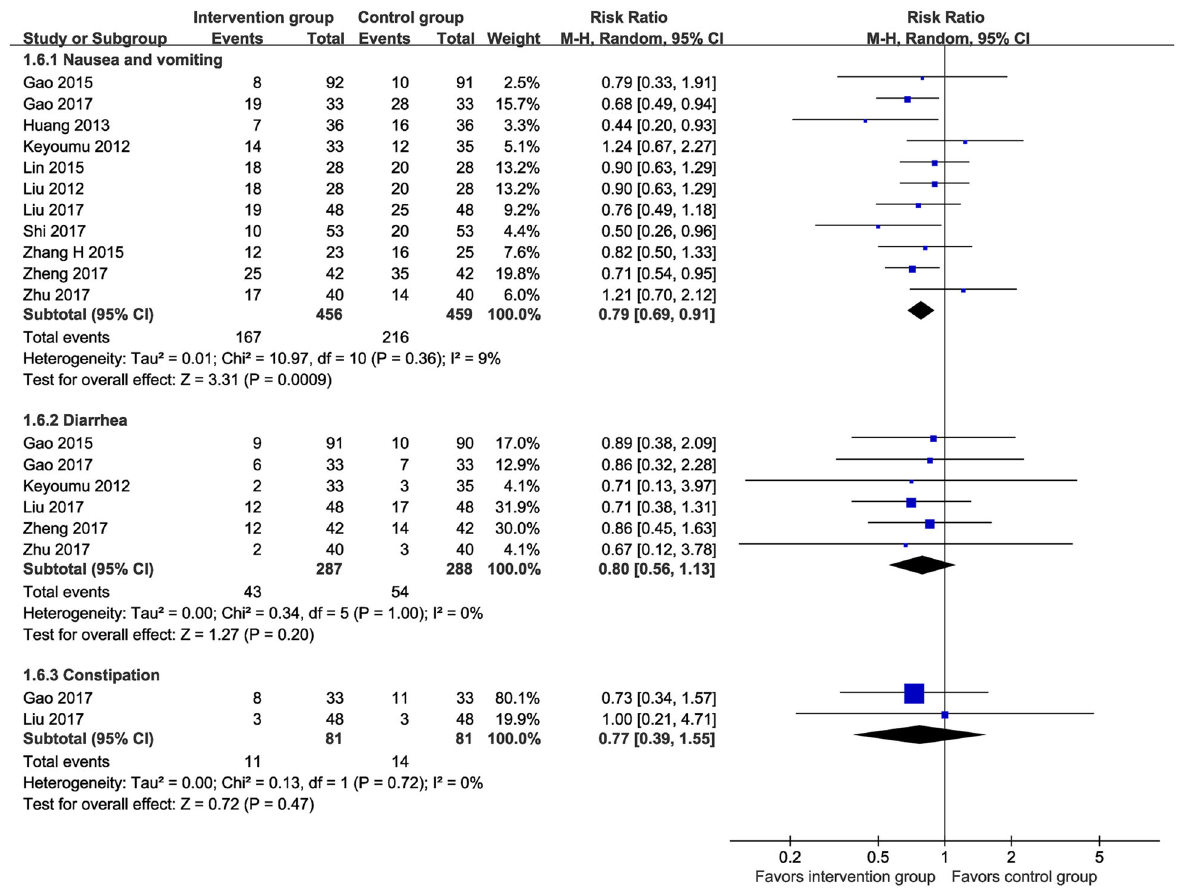
Fig. 8 Meta-analysis on incidence of gastrointestinal